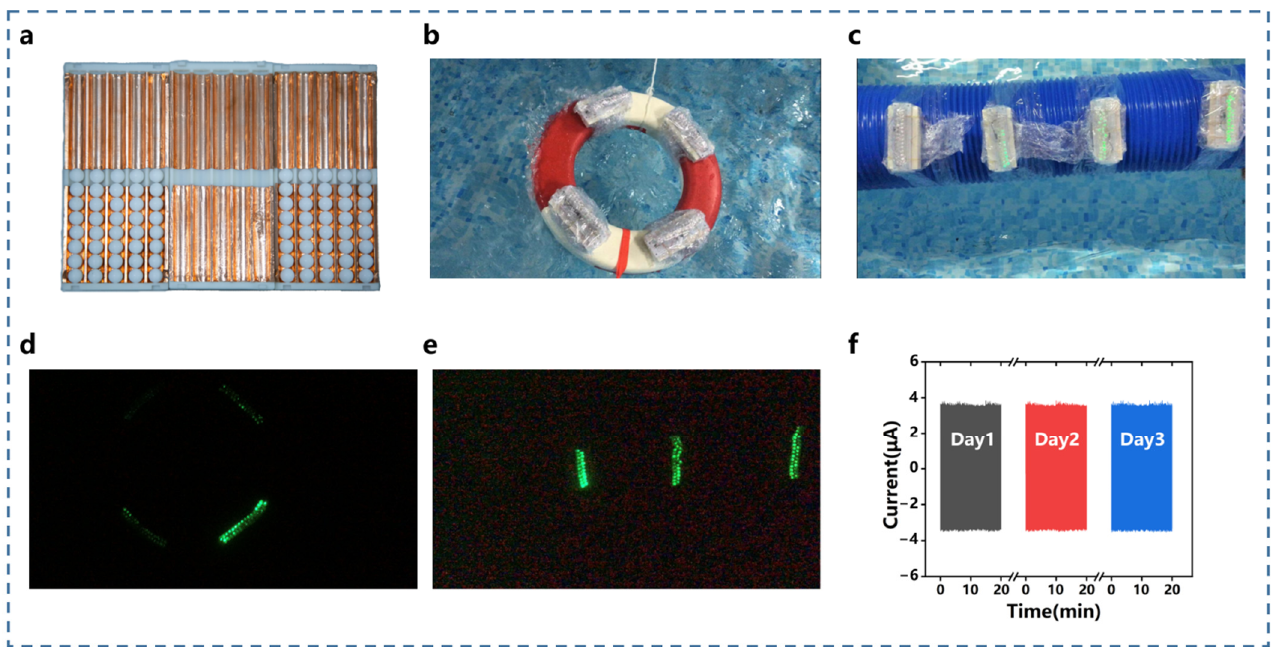
Figure 6. ( a ) The photograph of the folding structure, the MT-TENG. The photograph of the life buoy ( b ) and floating pipeline ( c ) integrated with the four MT-TENGs. LEDs are lit up simultaneously by the MT-TENG in the life buoy ( d ) and floating pipeline ( e ). ( f ) The result of robustness test.